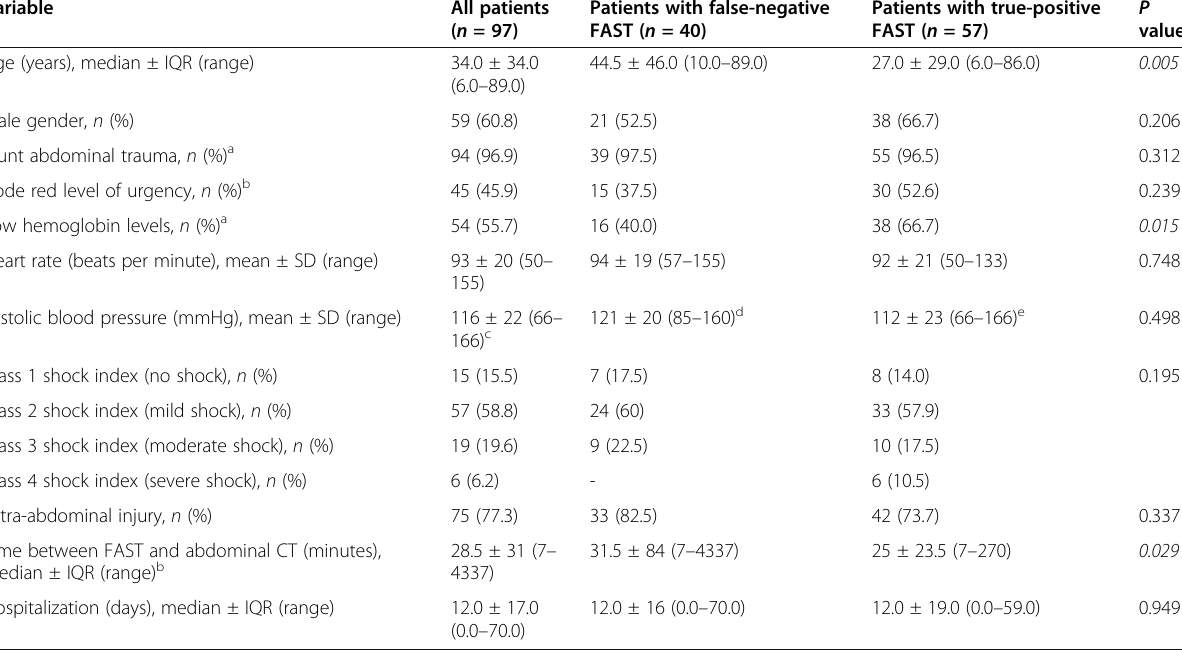
Table 1 Characteristics of the 97 included patients Variable All patients